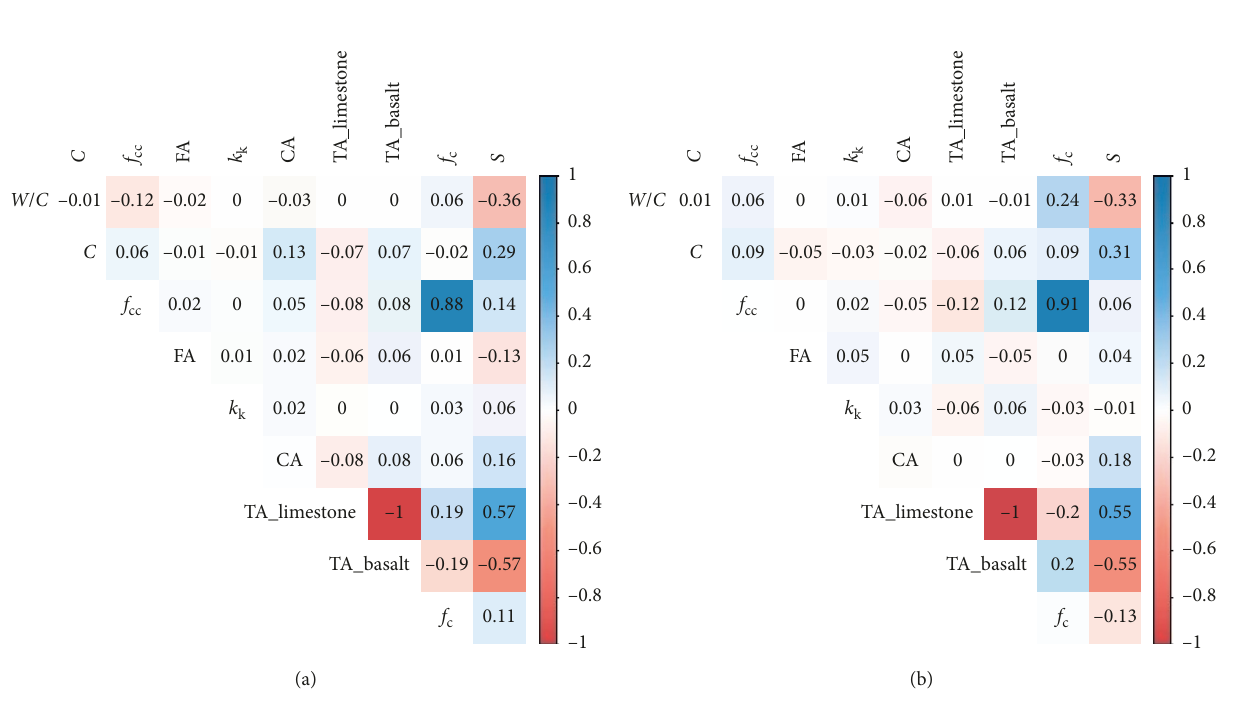
Figure 2: Correlation matrix of D 112 (a) and D 224 (b) Table 4: Shapiro–Wilk normality test results for datasets.